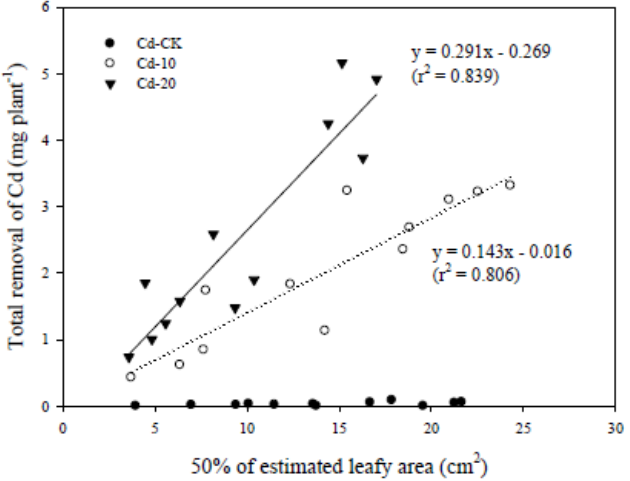
Figure 5. Linear relationship between 50% of estimated leafy area and the total removal of Cd by the edible parts of pak choi grown in various Cd-contaminated soils for 50 days. Replicates: n =